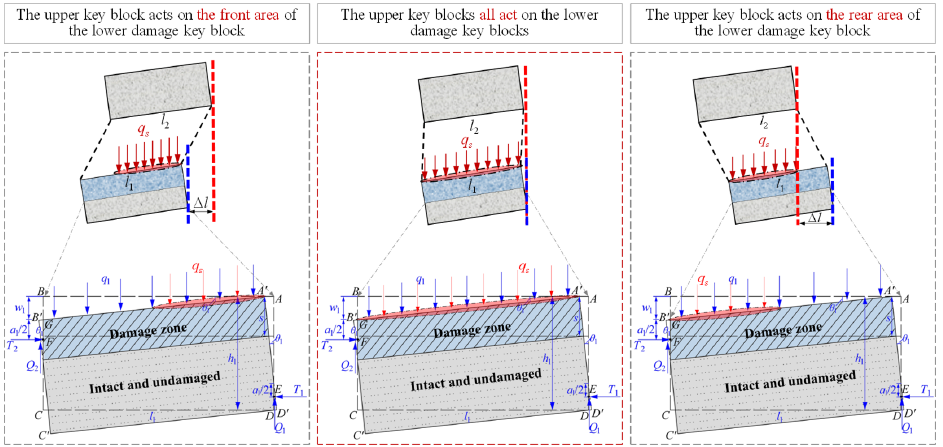
Figure 13. Interaction mechanical model of the upper and lower key blocks with different